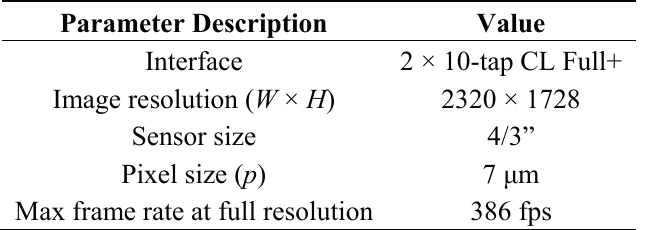
Table 3. Specifications of the implemented camera (AVT CL-400 Bonito